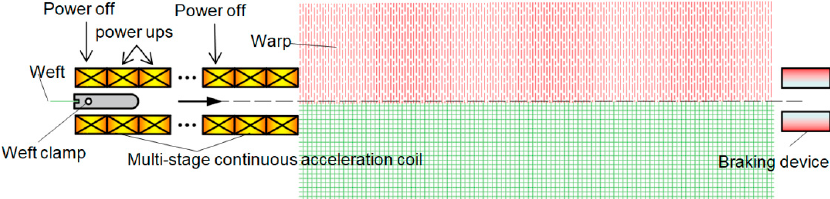
Figure 3. Figure 3. Schematic diagram of segmented combined continuous acceleration electromagnetic weft insertion.